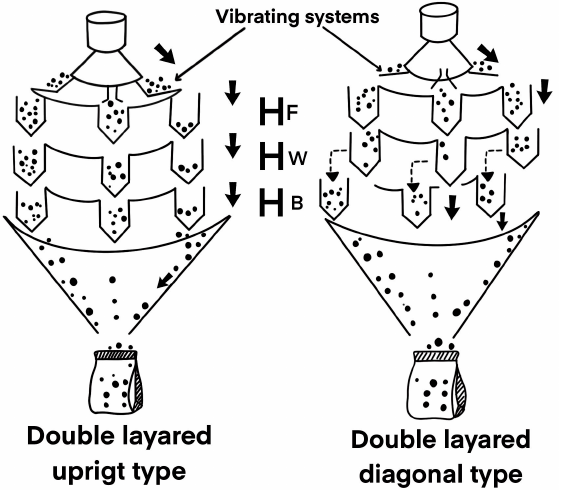
Figure 2. Upright and diagonal multihead weigher system and components.